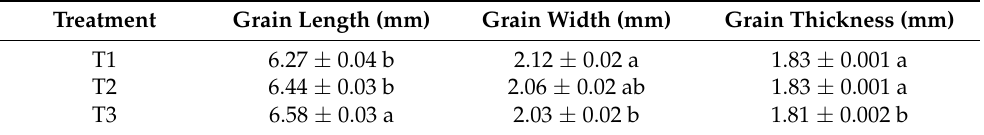
Table 2. Brown rice size in the different temperature groups.